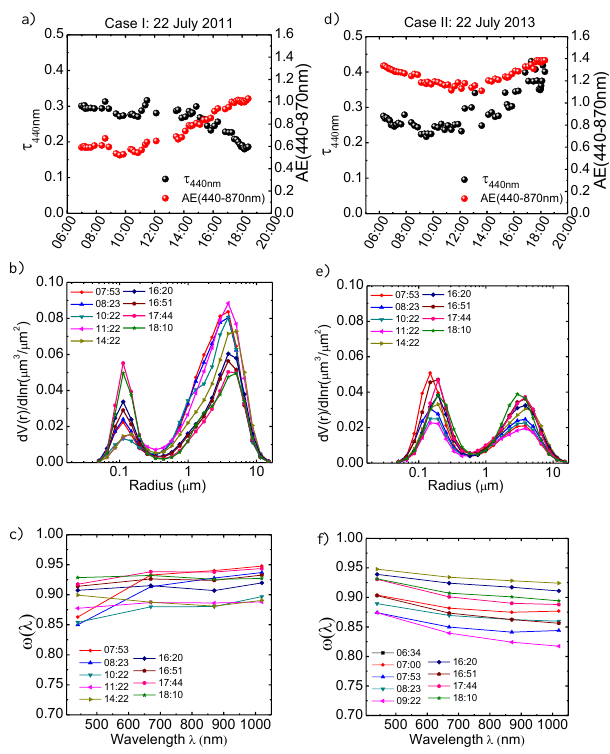
Figure 1. (a) AERONET τ 440 and AE(440–870) daily time series for Case I. (b) AERONET retrieved volume size distributions for Case I. (c) ω(λ) for Case I. (d) AERONET τ 440 and AE(440–870) daily time series for Case II. (e) AERONET retrieved volume size distributions for Case II. (f) ω(λ) for Case